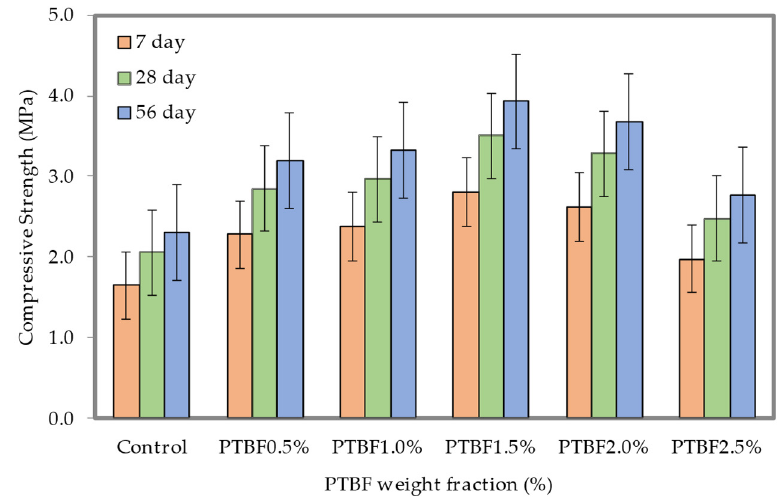
Figure 13. Compressive strength of 700 kg/m 3 density LFC with different weight fractions of PTBF.